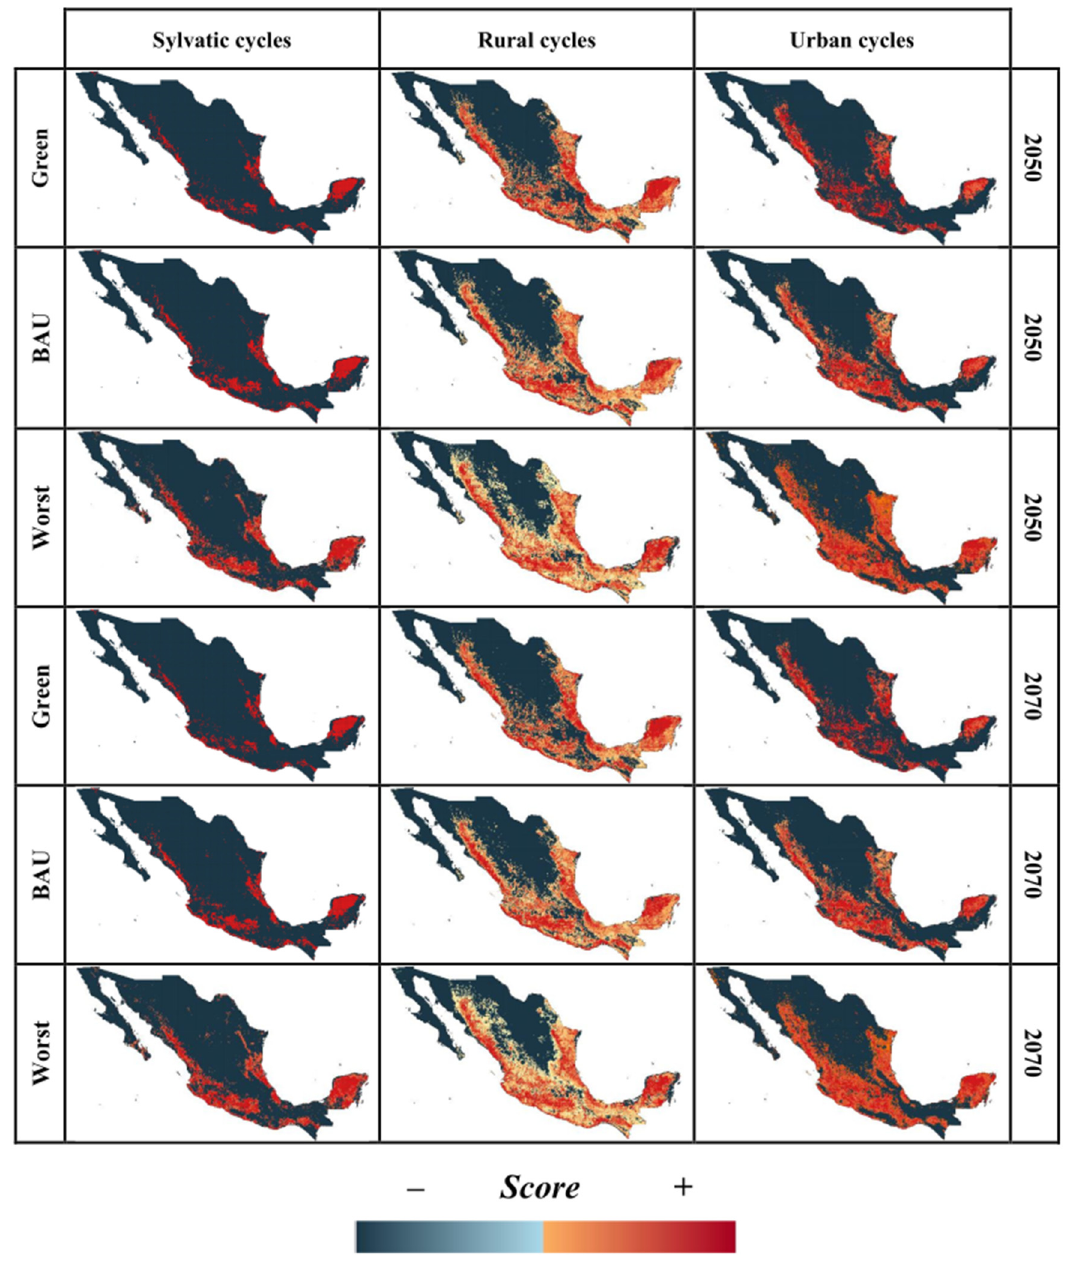
Figure 7. Predicted distribution of T. cruzi transmission cycles under future LUCC-CC scenarios ensembled for each year and each RCP scenario. The change from blue to red indicates a gradient from unsuitable (negative score) to suitable (positive score) ecological conditions.